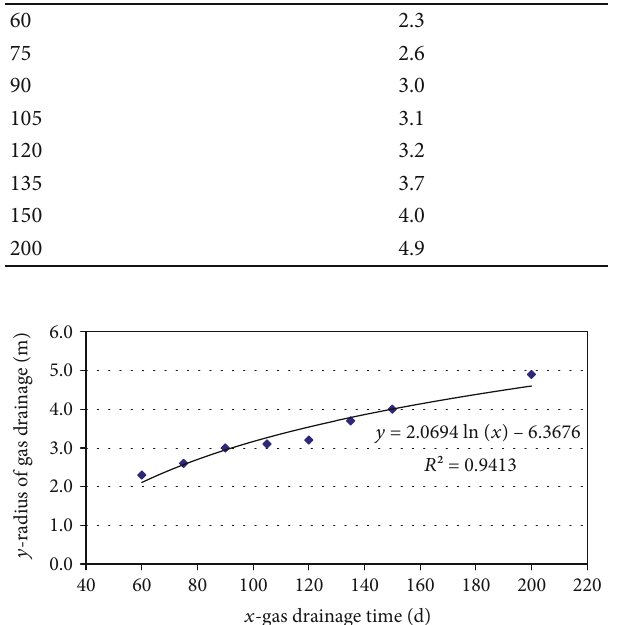
Table 3: Radius of gas drainage with pressure-relief (strike). Gas drainage time